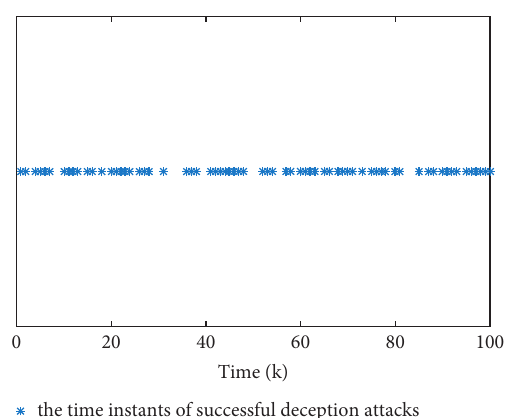
Figure 4: The time instants of successful deception attacks with α � 0 .